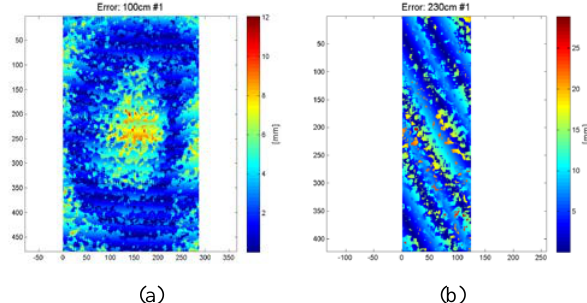
Figure 5. Distribution of fitting errors at ranges (a) 1 m and (b) 2.3 m. Based on the six measurement sets, the fitting plane